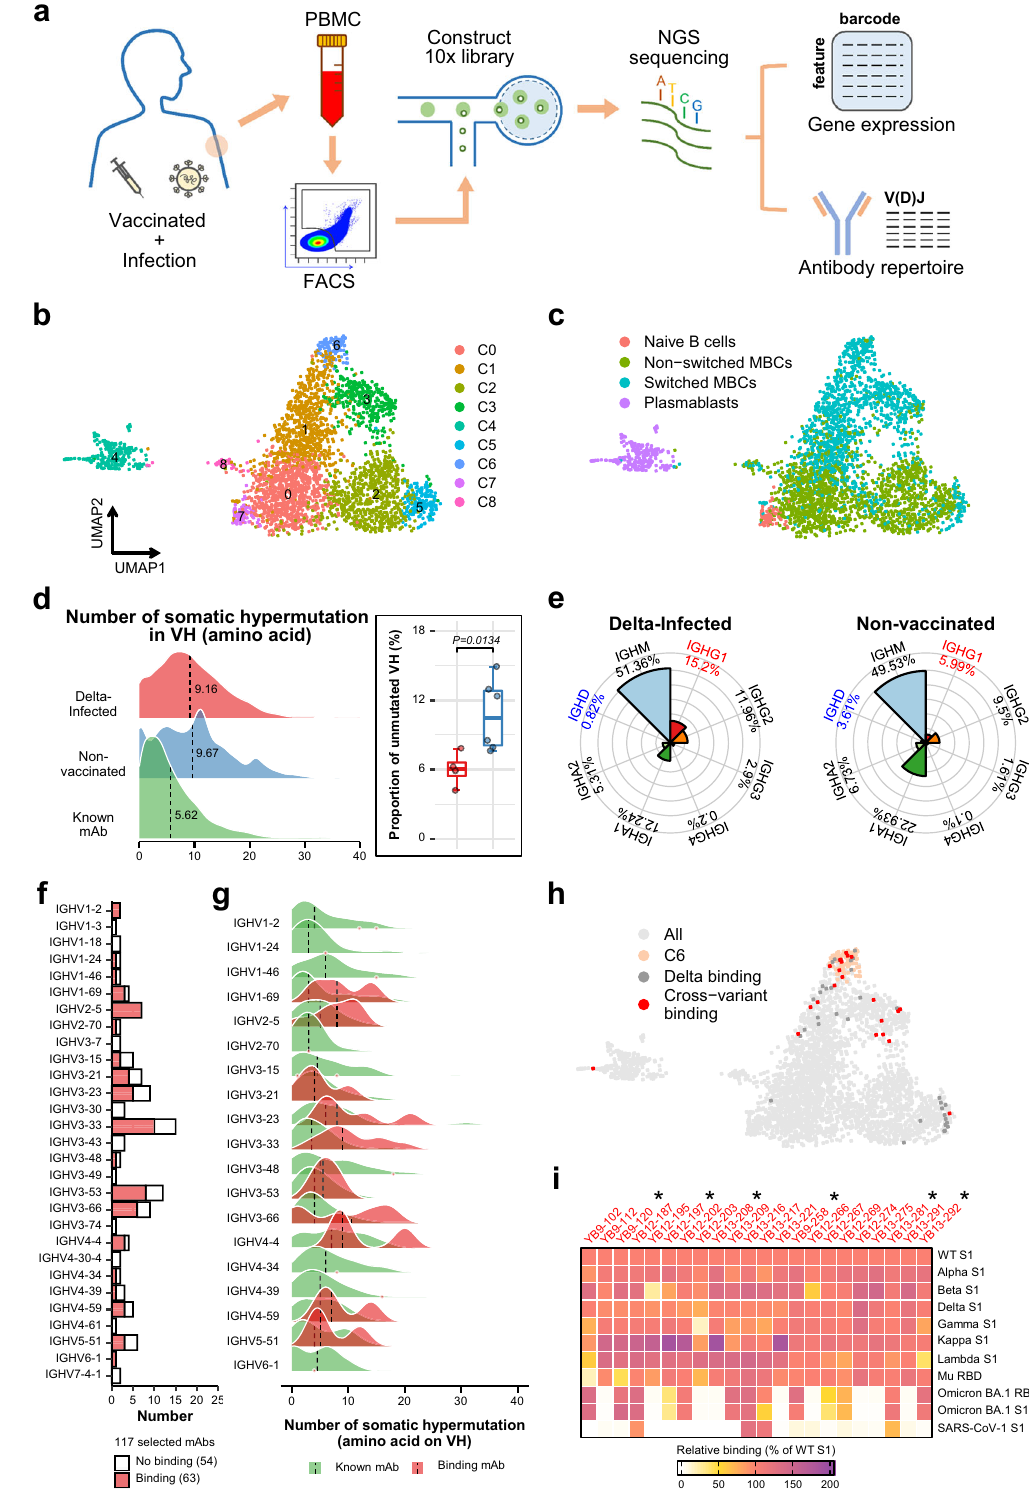
af fi nity towards wildtype, Delta and Omicron BA.1 spikes, while YB9- 258 binding to wildtype, Delta and Omicron BA.1 spikes exhibits lower responses in BLI assays (Fig. 2b). Substitutions in Delta and